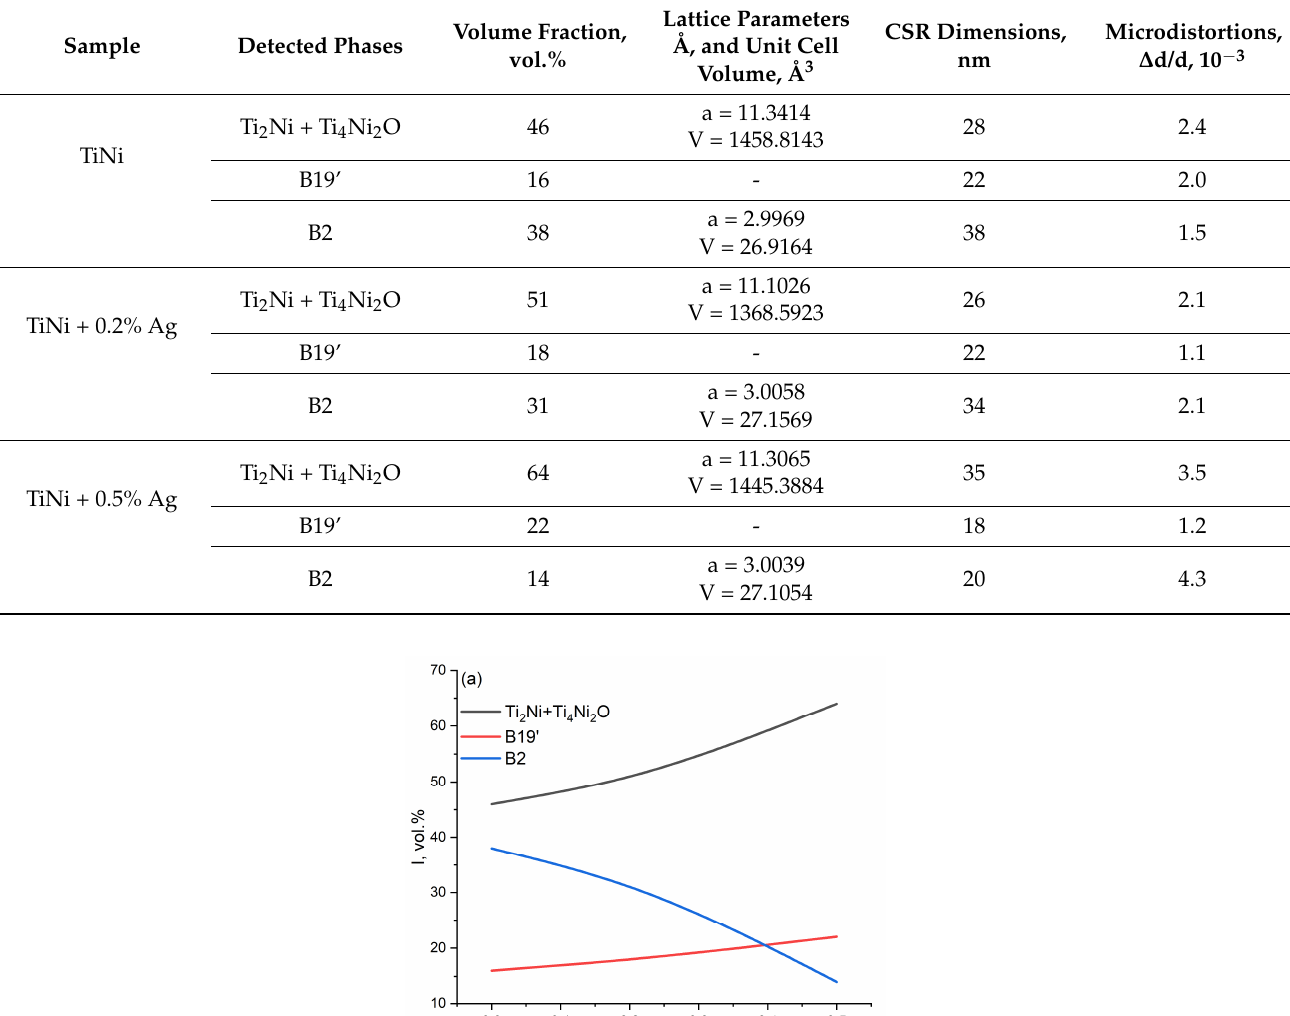
Table 1. X-ray analysis of TiNiAg alloys.